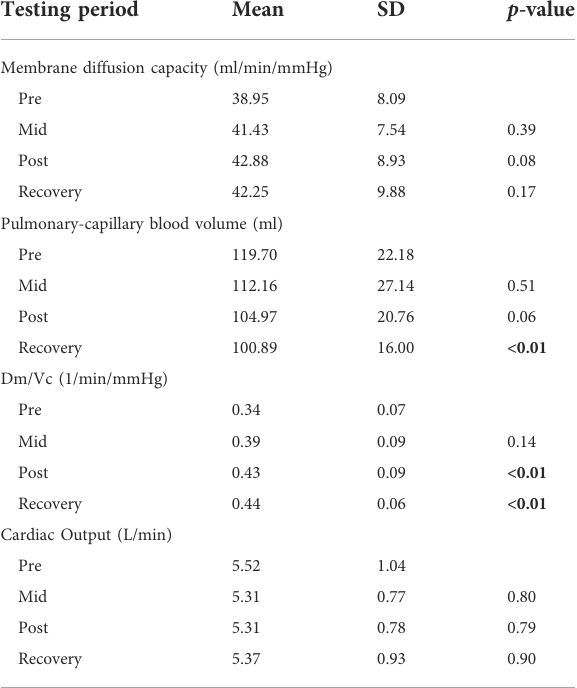
TABLE 5 The in fl uence of 120 s oscillations of 80/20 and 30/70 O2/ N2 concentrations on lung diffusion